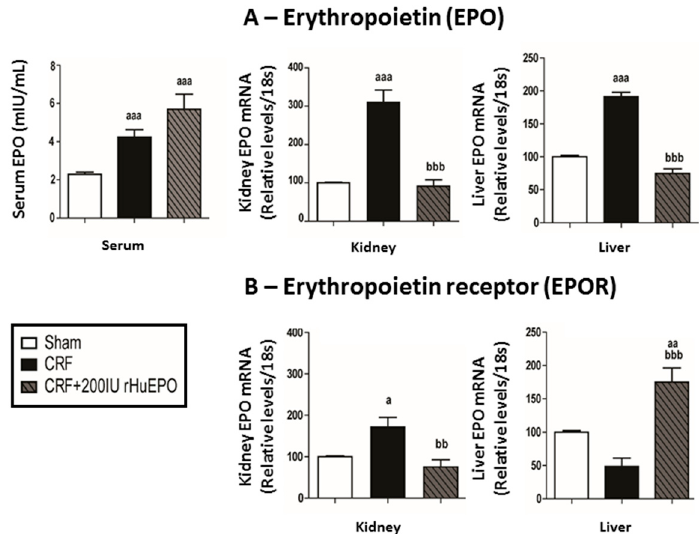
Figure 2. Erythropoietin (EPO) and erythropoietin receptor (EPOR): EPO in serum and kidney and